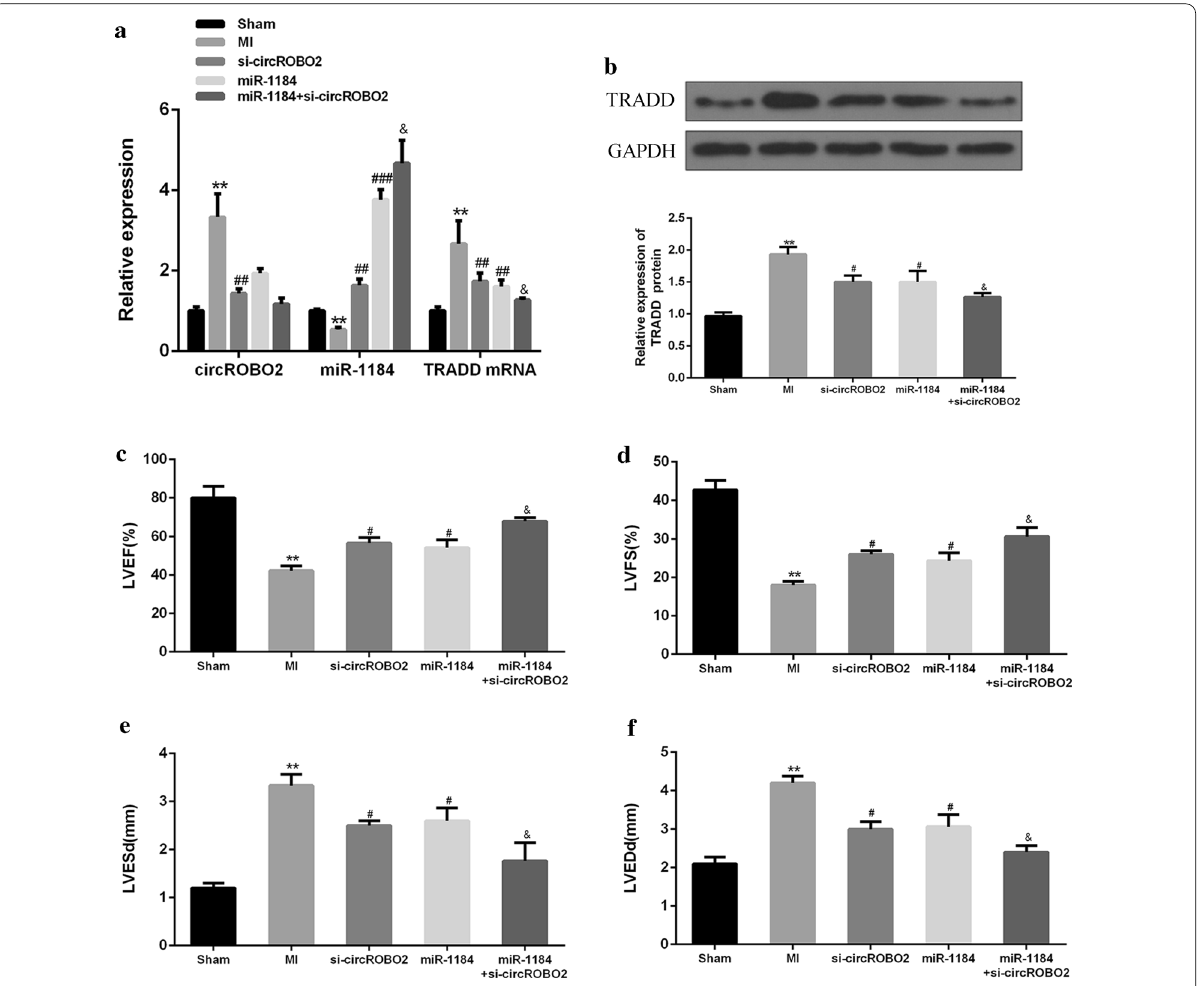
Fig. 5 Effects of overexpression of circROBO2 on myocardial function. a Relative expression levels of circROBO2, miR‑1184 and TRADD mRNA in mice group of sham, MI, si‑circROBO2 transfection, miR‑1184 transfection and miR‑1184 levels. LVEF ( c ), LVFS ( d ), Expression of LVESd ( e ) and LVEDd ( f ) in Sham, MI, si‑circROBO2, miR‑1184, and si‑circROBO2 cells were from three individual mice. * vs normoxic control group, # vs NC group and vs circROBO2 group. *** P < 0.001, ## P < 0.01 and & P <